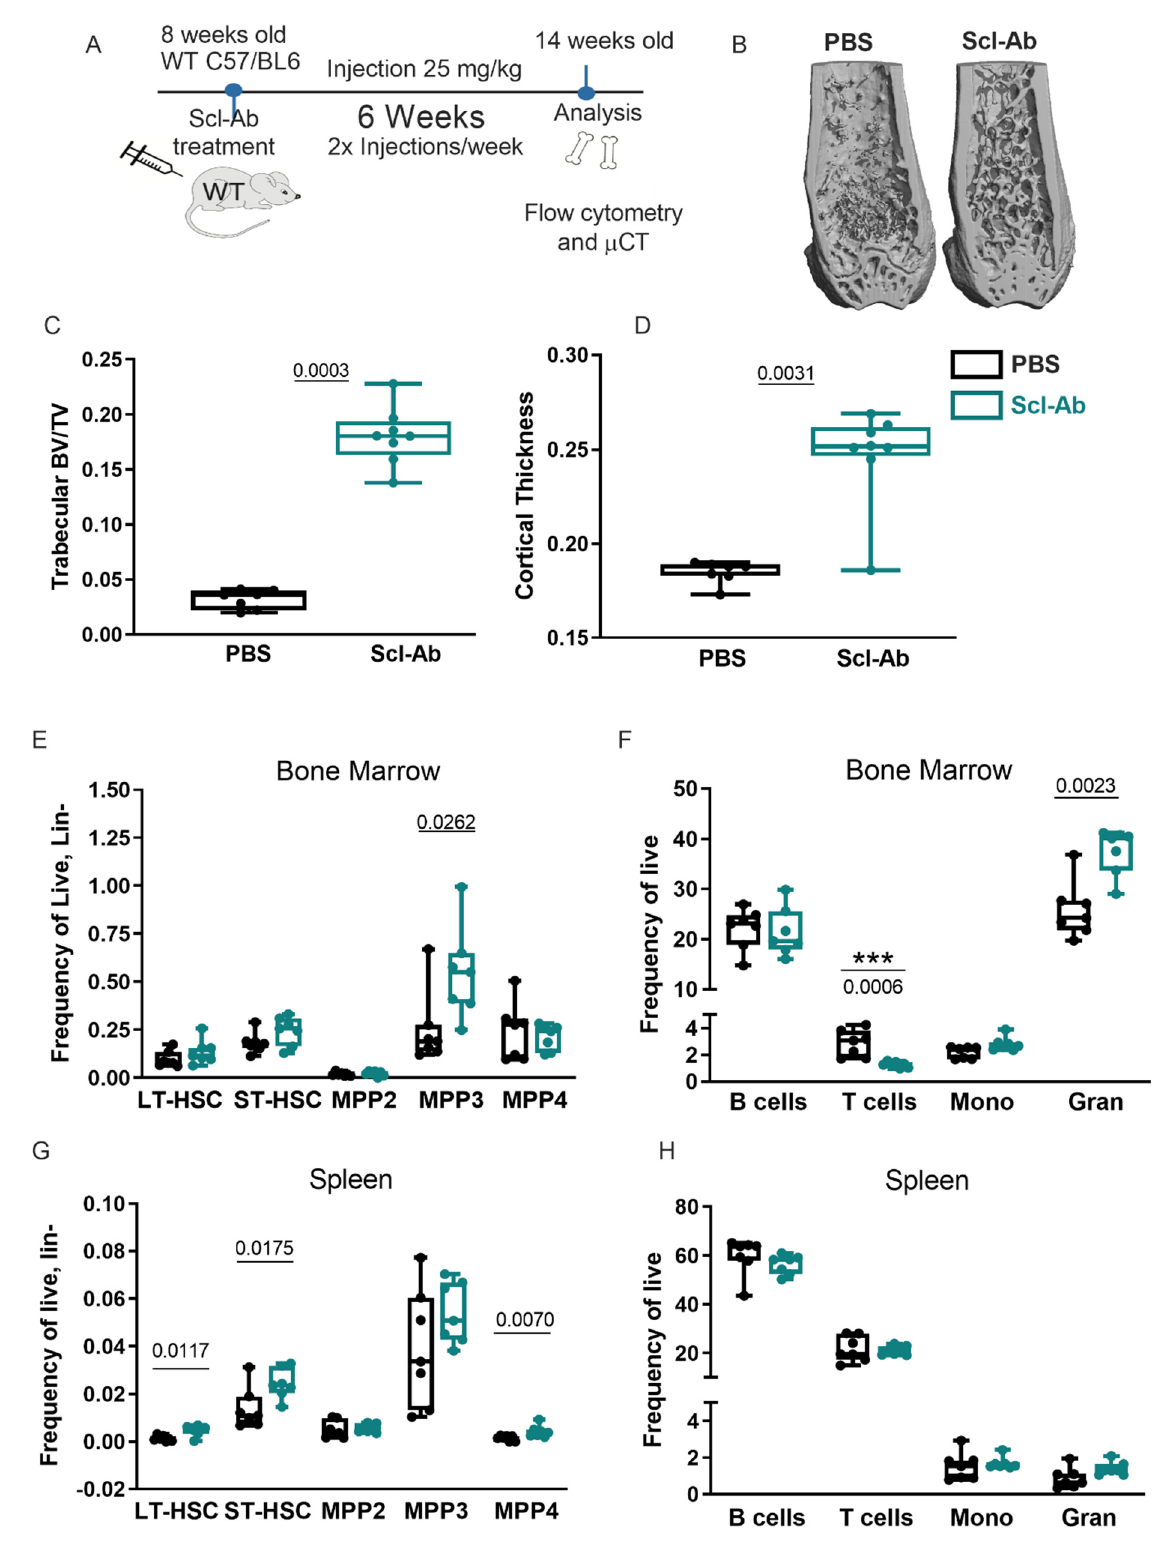
Figure 1. Sclerostin-depleting antibodies change hematopoietic differentiation. ( A ) Experimental scheme for Scl-Ab treatment and analysis; ( B ) micro-CT images of femurs from PBS and Scl-Ab-treated mice; ( C ) trabecular BV/TV; ( D ) cortical bone mineral density; ( E ) bone marrow frequency of LSK progenitors; ( F ) bone marrow frequency of mature lineages; ( G ) splenic frequency of LSK progenitors; ( H ) splenic frequency of mature lineages. Female mice of 8 weeks of age were used for this study ( n = 7 for each group). The actual p -values are shown, underlined.